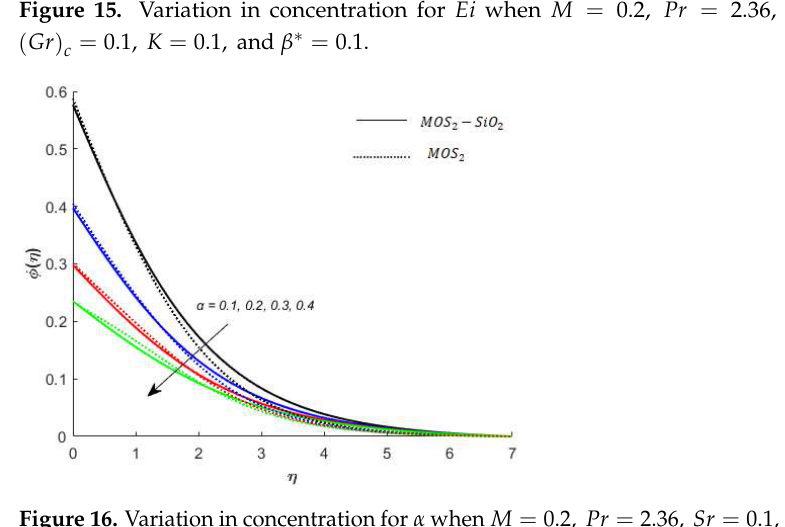
Figure 16. Variation in concentration for 𝛼 when 𝑀 = 0.2, 𝑃𝑟 = 2.36,𝑆𝑟 = 0.1,𝑆𝑐 = 0.8, (𝐺𝑟) (cid:3030) = 0.1,𝐾 = 0.1,and 𝛽 ∗ = 0.1 .